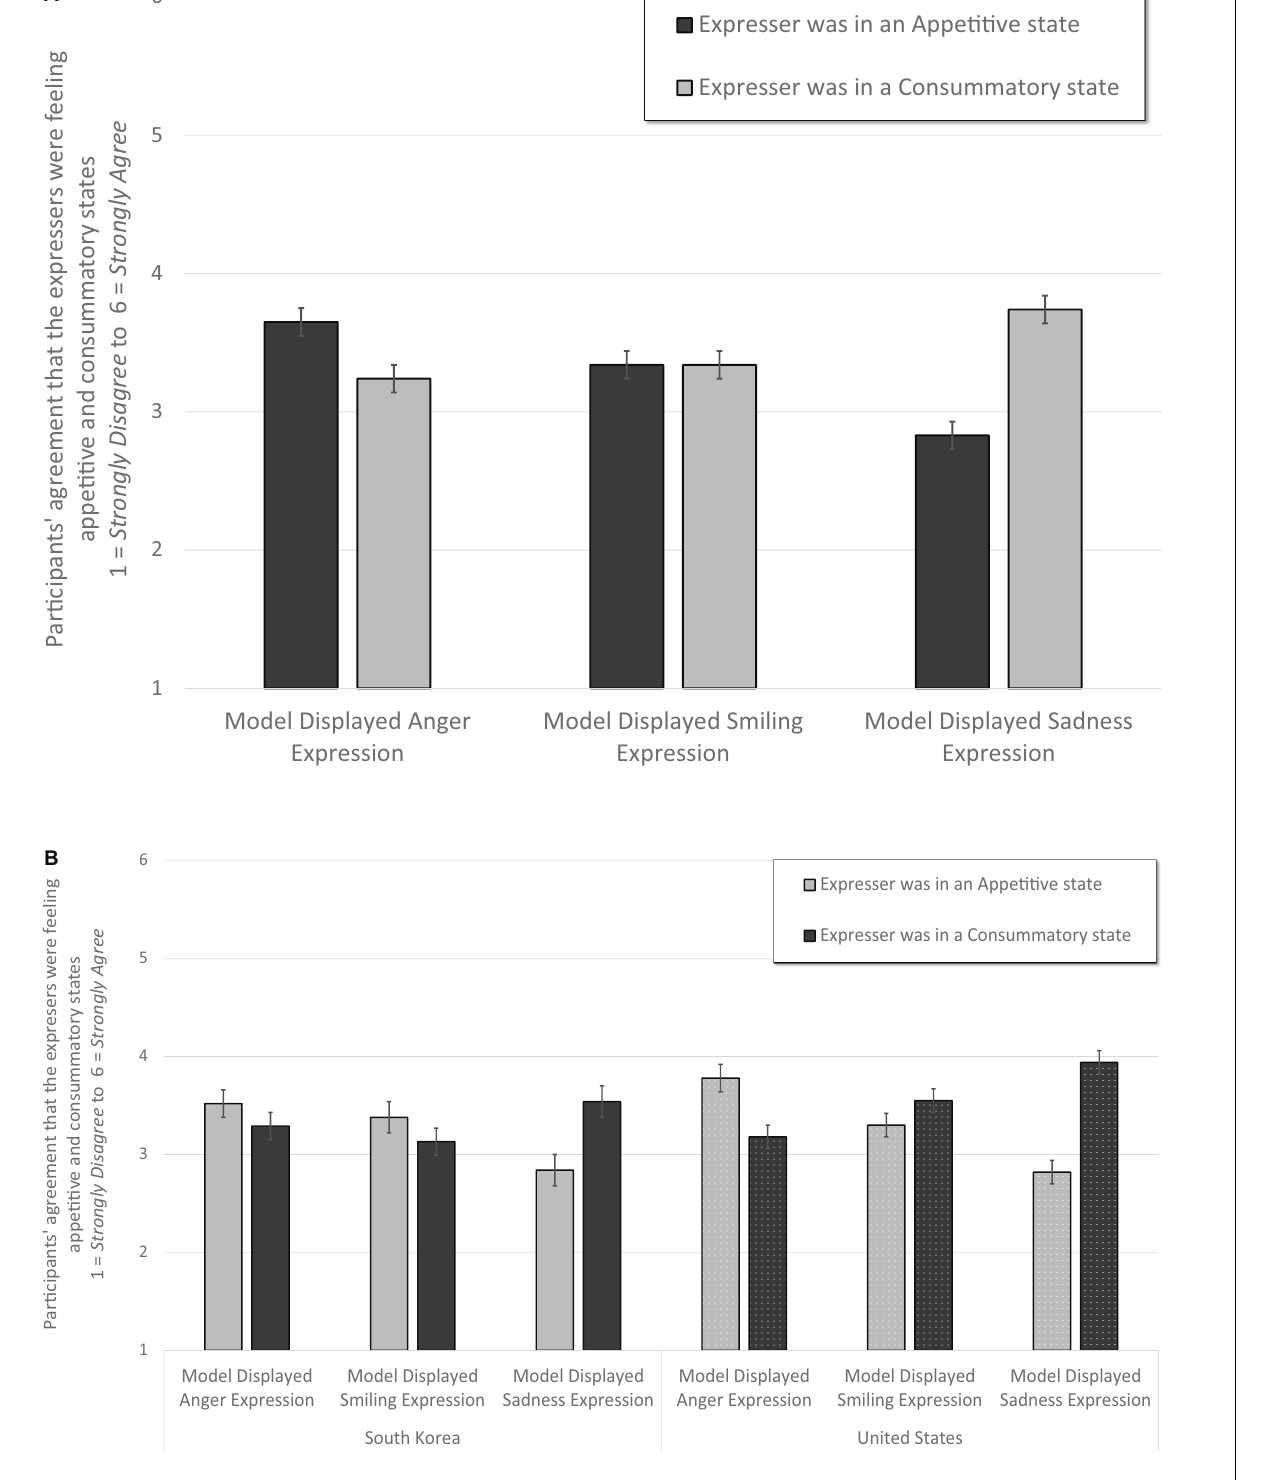
Model Displayed Smiling Expression